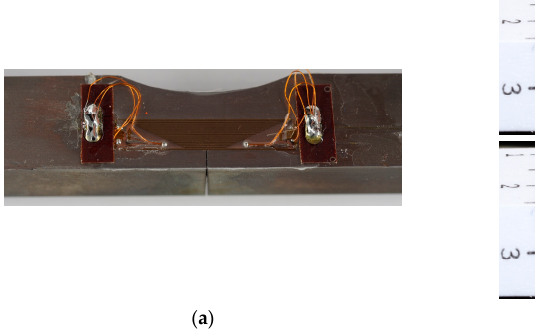
( b ) Figure 6. ( a ) Strain signal measurement of two crack gauges at top and bottom side over a number of cycles for a specimen of the series 15; ( b ) Crack lengths derived from strain signals. 3.6. Statistical Evaluation of Fatigue Test Results In the statistical evaluation, the following parameters of the S–N curves were identified: • endurable nominal stress at the knee point Δ𝜎 (cid:3041) , (cid:3038) , • number of cycles at the knee point 𝑁 (cid:3038) , • slope of the S–N curve in the high cycle fatigue regime ( 𝑁 ≤ 𝑁 (cid:3038) ) 𝑘 , • slope of the S–N curve in the very high cycle regime ( 𝑁 > 𝑁 (cid:3038) ) 𝑘 ∗ . Since 𝑘 ∗ is quite difficult to identify [40], it was set to 𝑘 ∗ = 45 according to Sonsino [41]. The statistical evaluation of the S–N curve was performed using the maximum likelihood method [40]. A mathematical best fit S–N curve was calculated, Figure 7 (left), by varying the knee point, Figure 7 (right), and identifying the one with the highest